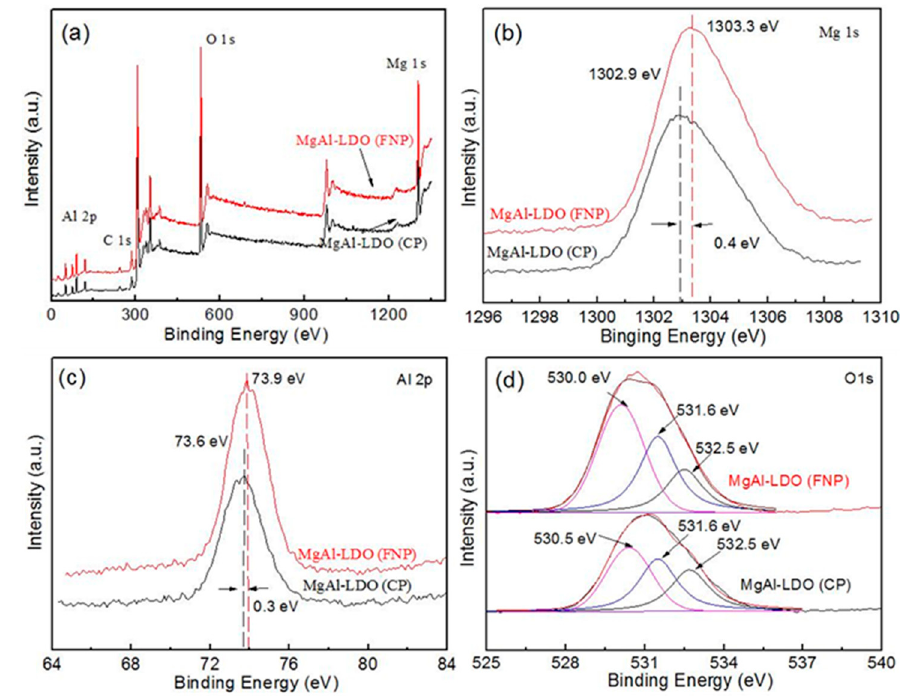
Figure 5. X-ray photoelectron spectroscopy (XPS) spectra of the as-obtained MgAl-LDO (CP) and MgAl-LDO (FNP). ( a ) Survey spectra, ( b ) Mg, ( c ) Al, and ( d ) O.